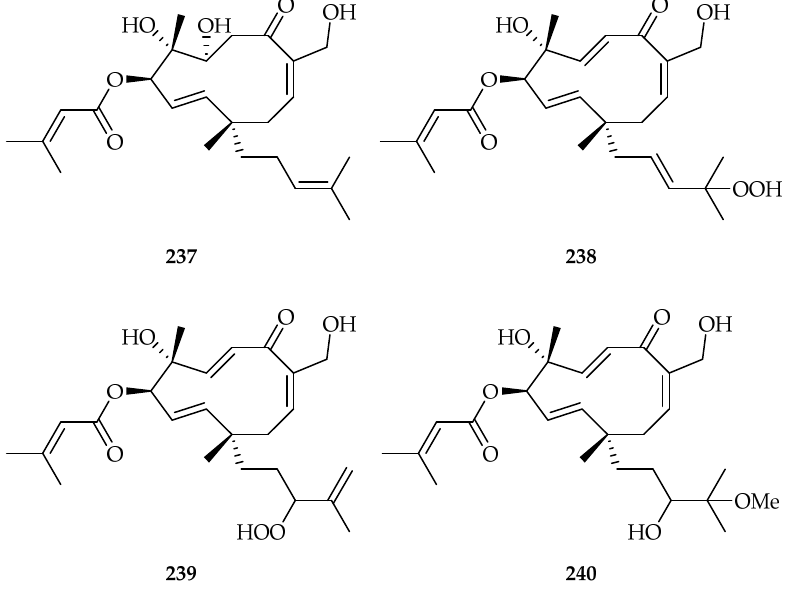
Figure 94. Structures of vibsanol I 237 [148], 15-hydroperoxyvibsanol A 238 [148], 14-hydroperoxy- vibsanol B 239 [148], and 15- O -methylvibsanin U 240 [148].